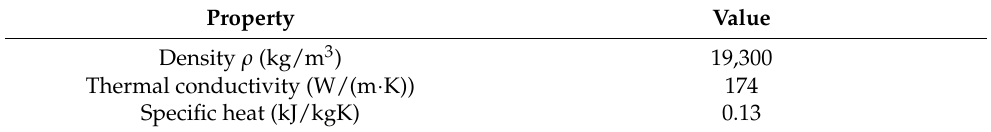
Table 3. Physical properties of tungsten at 25 ◦ C.